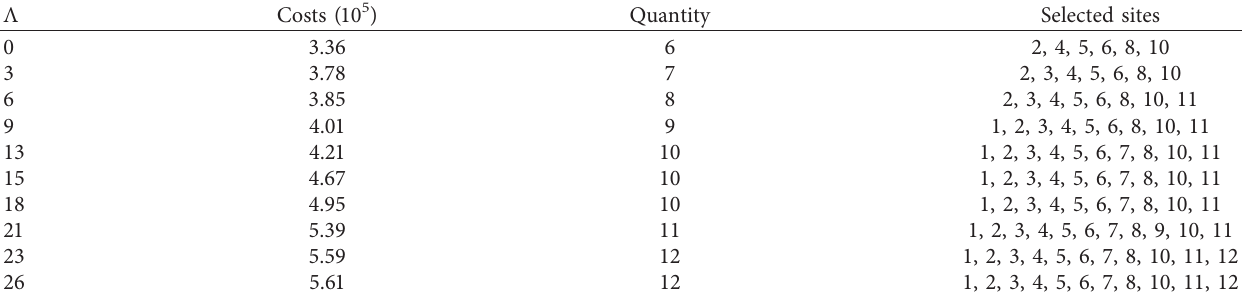
Table 8: Optimal scheme in MIRP-polyhedron set.